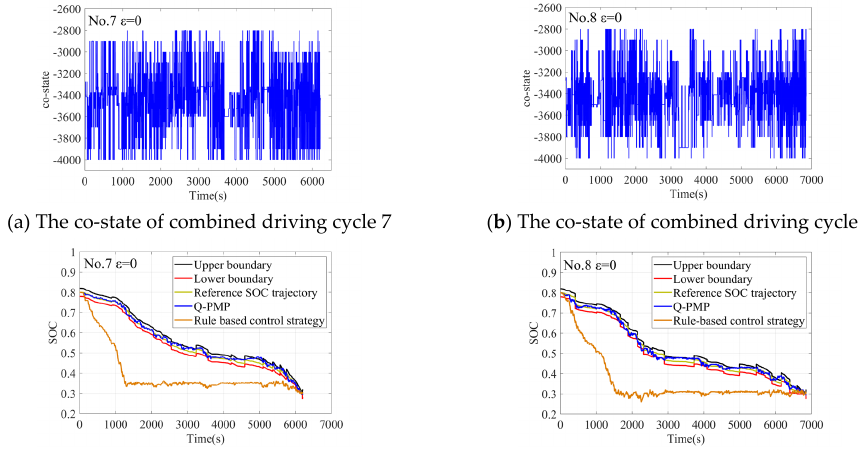
Figure 16. Offline verification results of combined driving cycles 7 and 8.